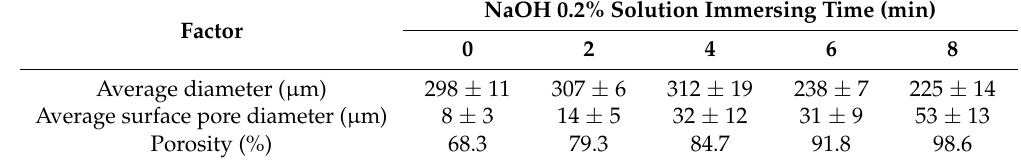
Table 4. Structure characterization of PLGA 3% ( w / v ) microspheres obtained with